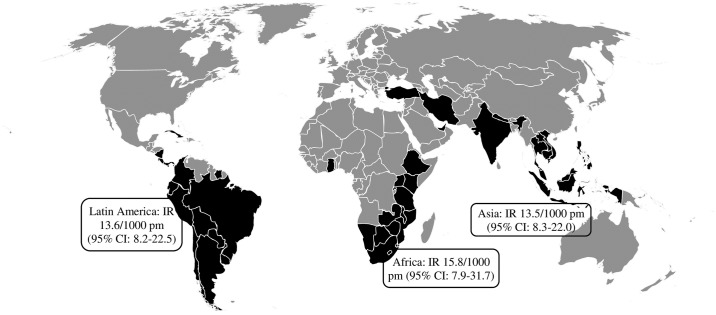
World map: Countries visited by the participants with evidence suggestive of recent dengue virus infection.Reprinted from LCR under a CC BY license, with permission from LCR, original copyright 2017.